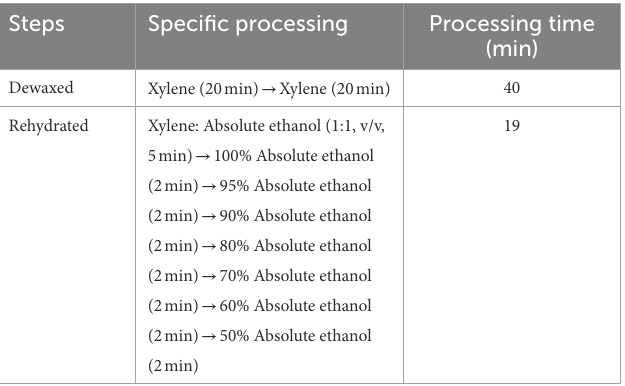
TABLE 2 Dewaxing and rehydration